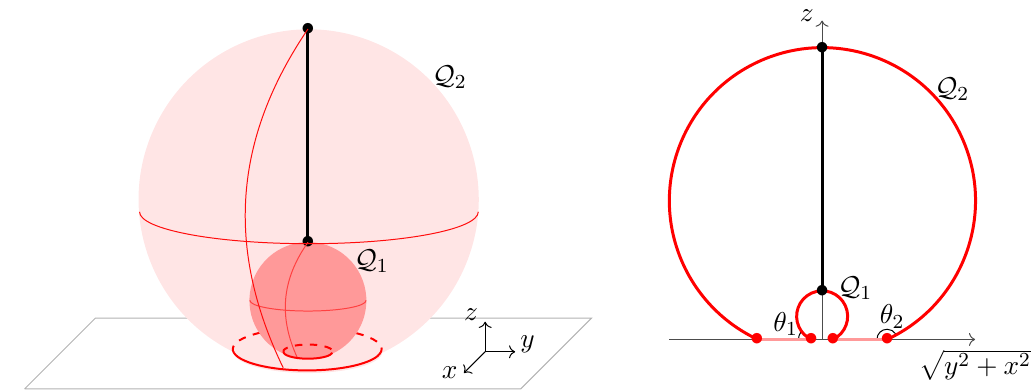
Figure 11. On the left, we show the region M bounded by two spherical branes Q 1 and Q 2 . On the right, we take a transverse slice to better depict the angles θ 1 and θ 2 that Q 1 and Q 2 respectively make with the conformal boundary. The minimal geodesic between the two branes, which is ultimately the main object of interest in this section, is shown in